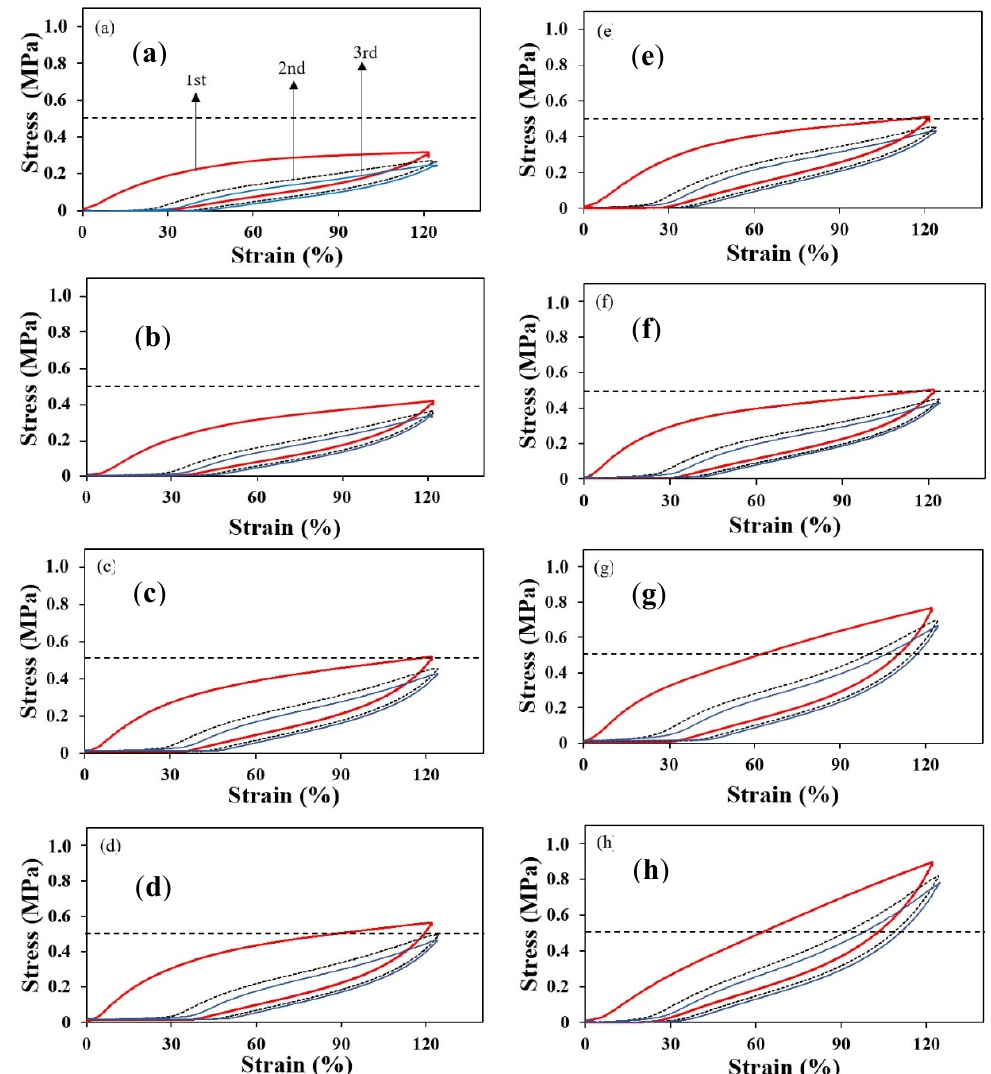
Figure 7. Mullins effect of NR/MCC ( left ) and NR/NCC ( right ) composites when the amount of either MCC or NCC were at ( a , e ) 25 phr, ( b , f ) 50 phr, ( c , g ) 75 phr, and ( d , h ) 100 phr.